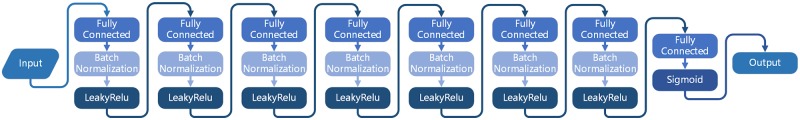
The detail of each layer.